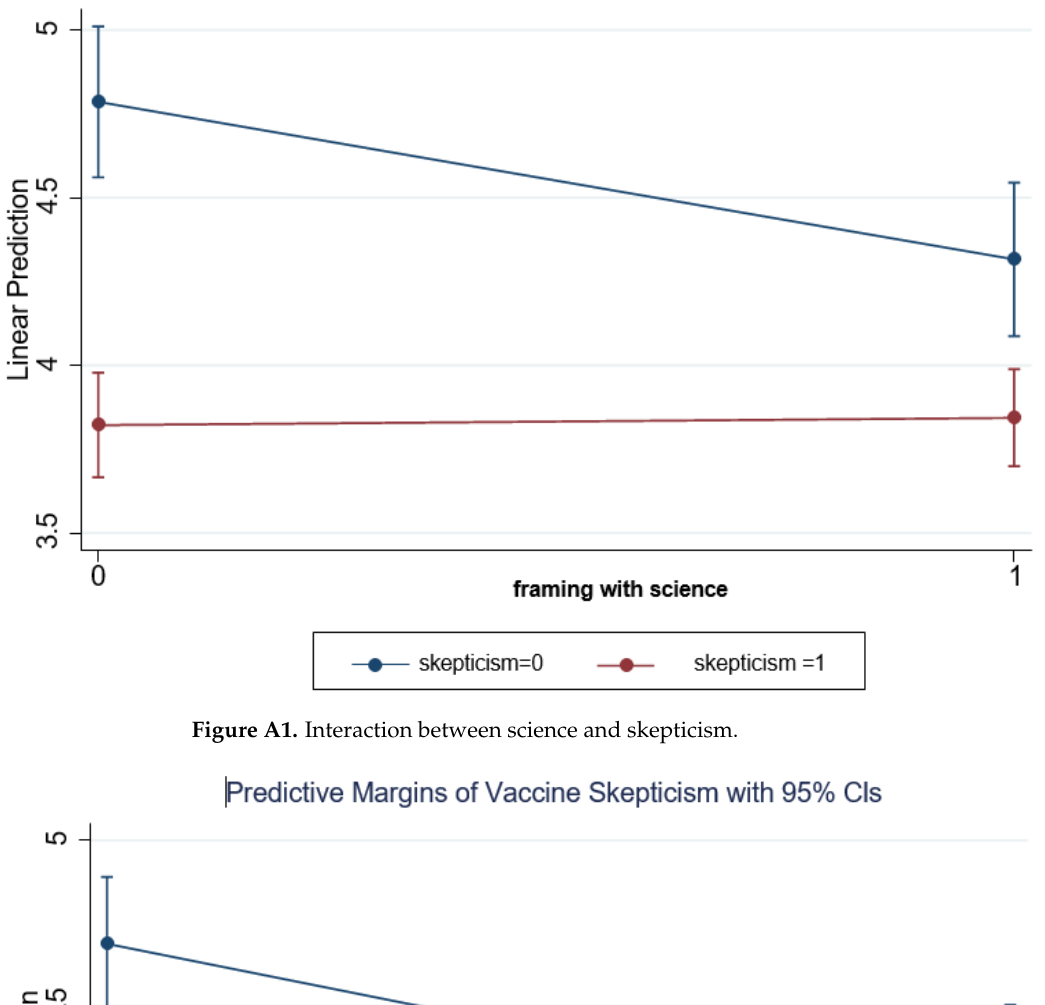
Figure A1. Interaction between science and skepticism.